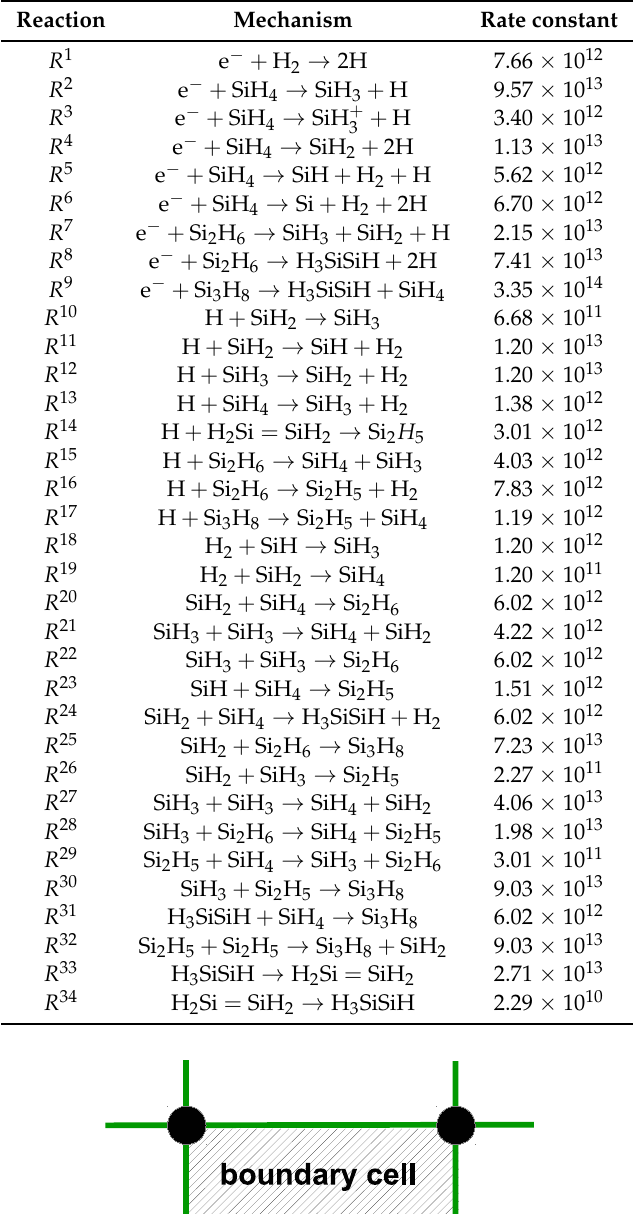
Table 1. Reactions included in the gas-phase model. Note: Rate constants have units of cm 3 /s and have been adopted from the collection prepared by Kushner et al. [22].